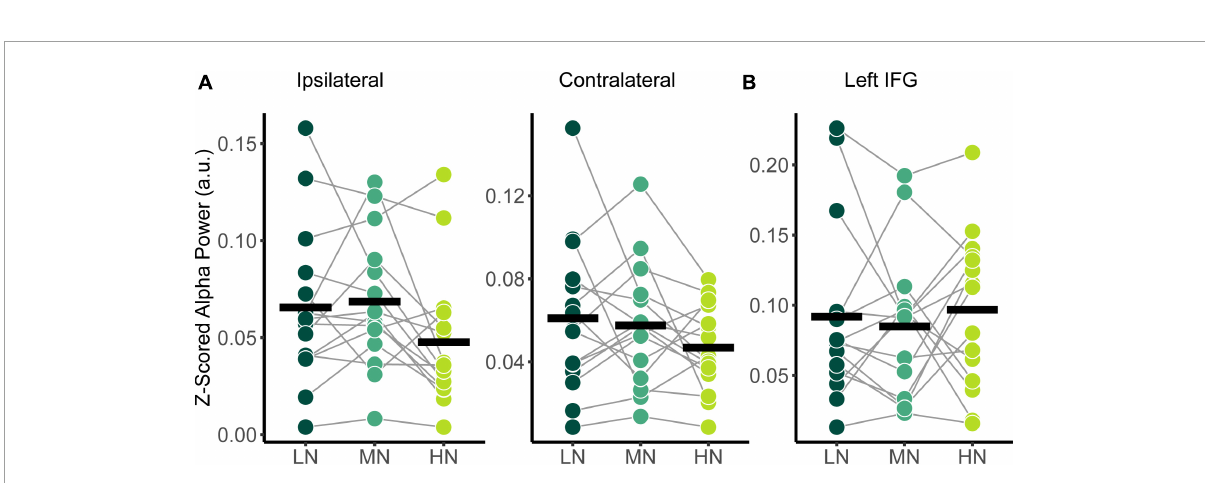
FIGURE4 Comparison of relative alpha power between audiovisual Low-Noise (LN), Moderate-Noise (MN), and High-Noise (HN) conditions for the (A) ipsilateral and contralateral superior-parietal region and (B) left inferior-frontal gyrus (IFG) ROIs. No statistically significant differences were